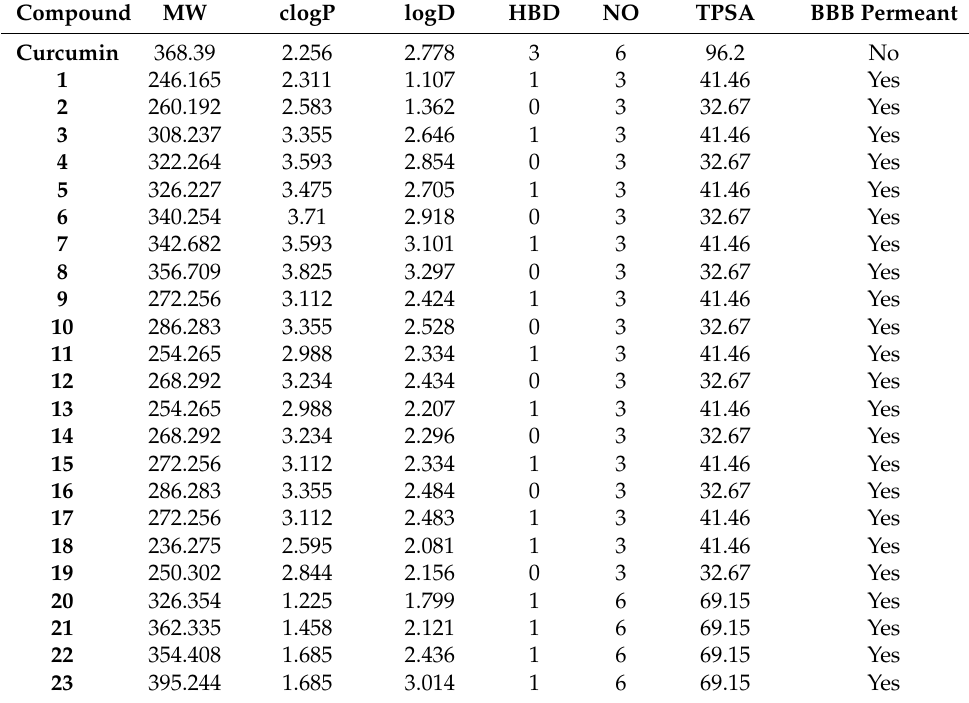
Table 2. Calculated physicochemical properties of 1,5-Benzodiazepin-2(3 H )-ones